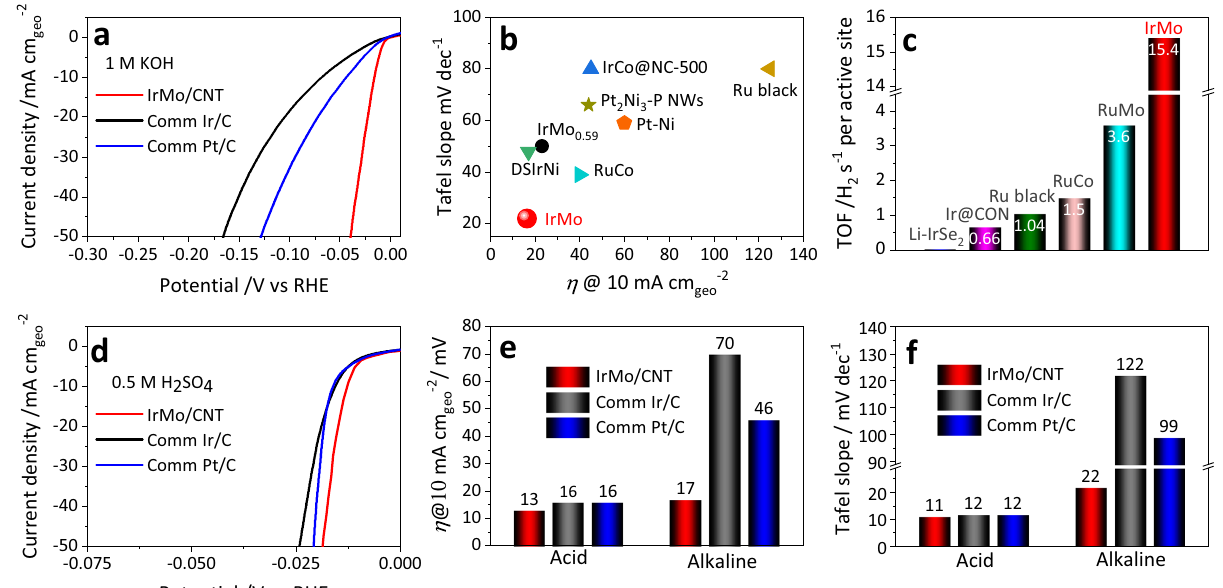
Fig. 3 | HER performance of IrMo/CNT, commercial Ir/C, and Pt/C. a HER polarization curves in 1M KOH. b Comparison of the HER Tafel slope and the overpotential ( η ) at 10mAcm − 2 ( η 10 ) in 1M KOH of IrMo/CNT with some reported preciouselectrocatalysts 14,45 – 50 . c ComparisonoftheHERTOFofIrMo/CNTwiththe